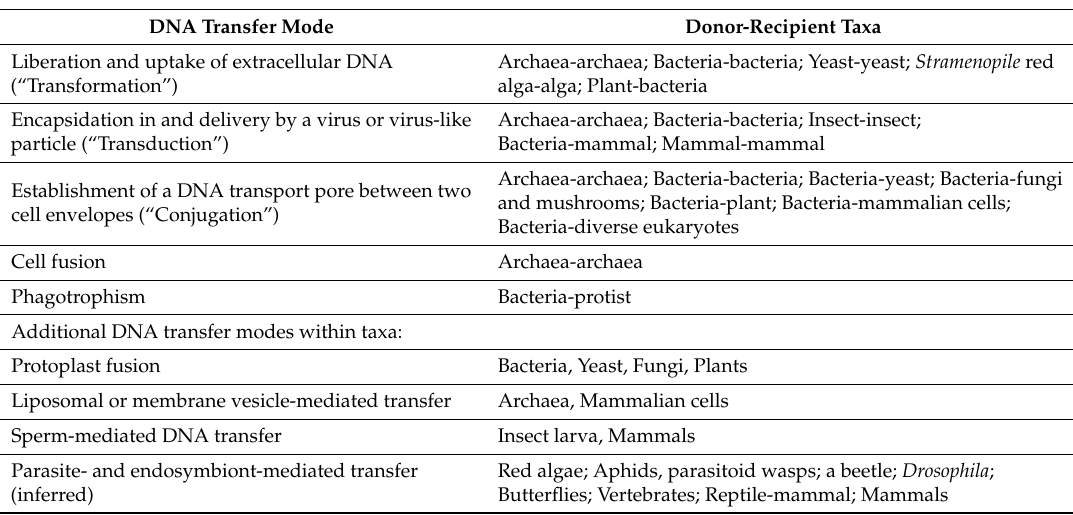
Table 6. Modes of Horizontal DNA